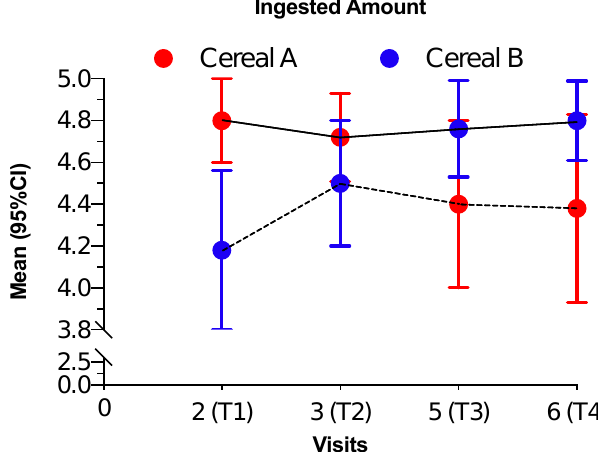
Figure 4. Scores for ingested amount in each visit for both intervention groups. Scale—0 = he / she ate nothing to 5 = he / she ate everything. Values are shown as mean and 95% confidence intervals. Continuous line represents the intervention group AB and the discontinuous line represents the intervention group BA. Cereal A—0% whole grain and 24 g / 100 g sugar; Cereal B—50% whole grain and 12 g / 100 g sugars.